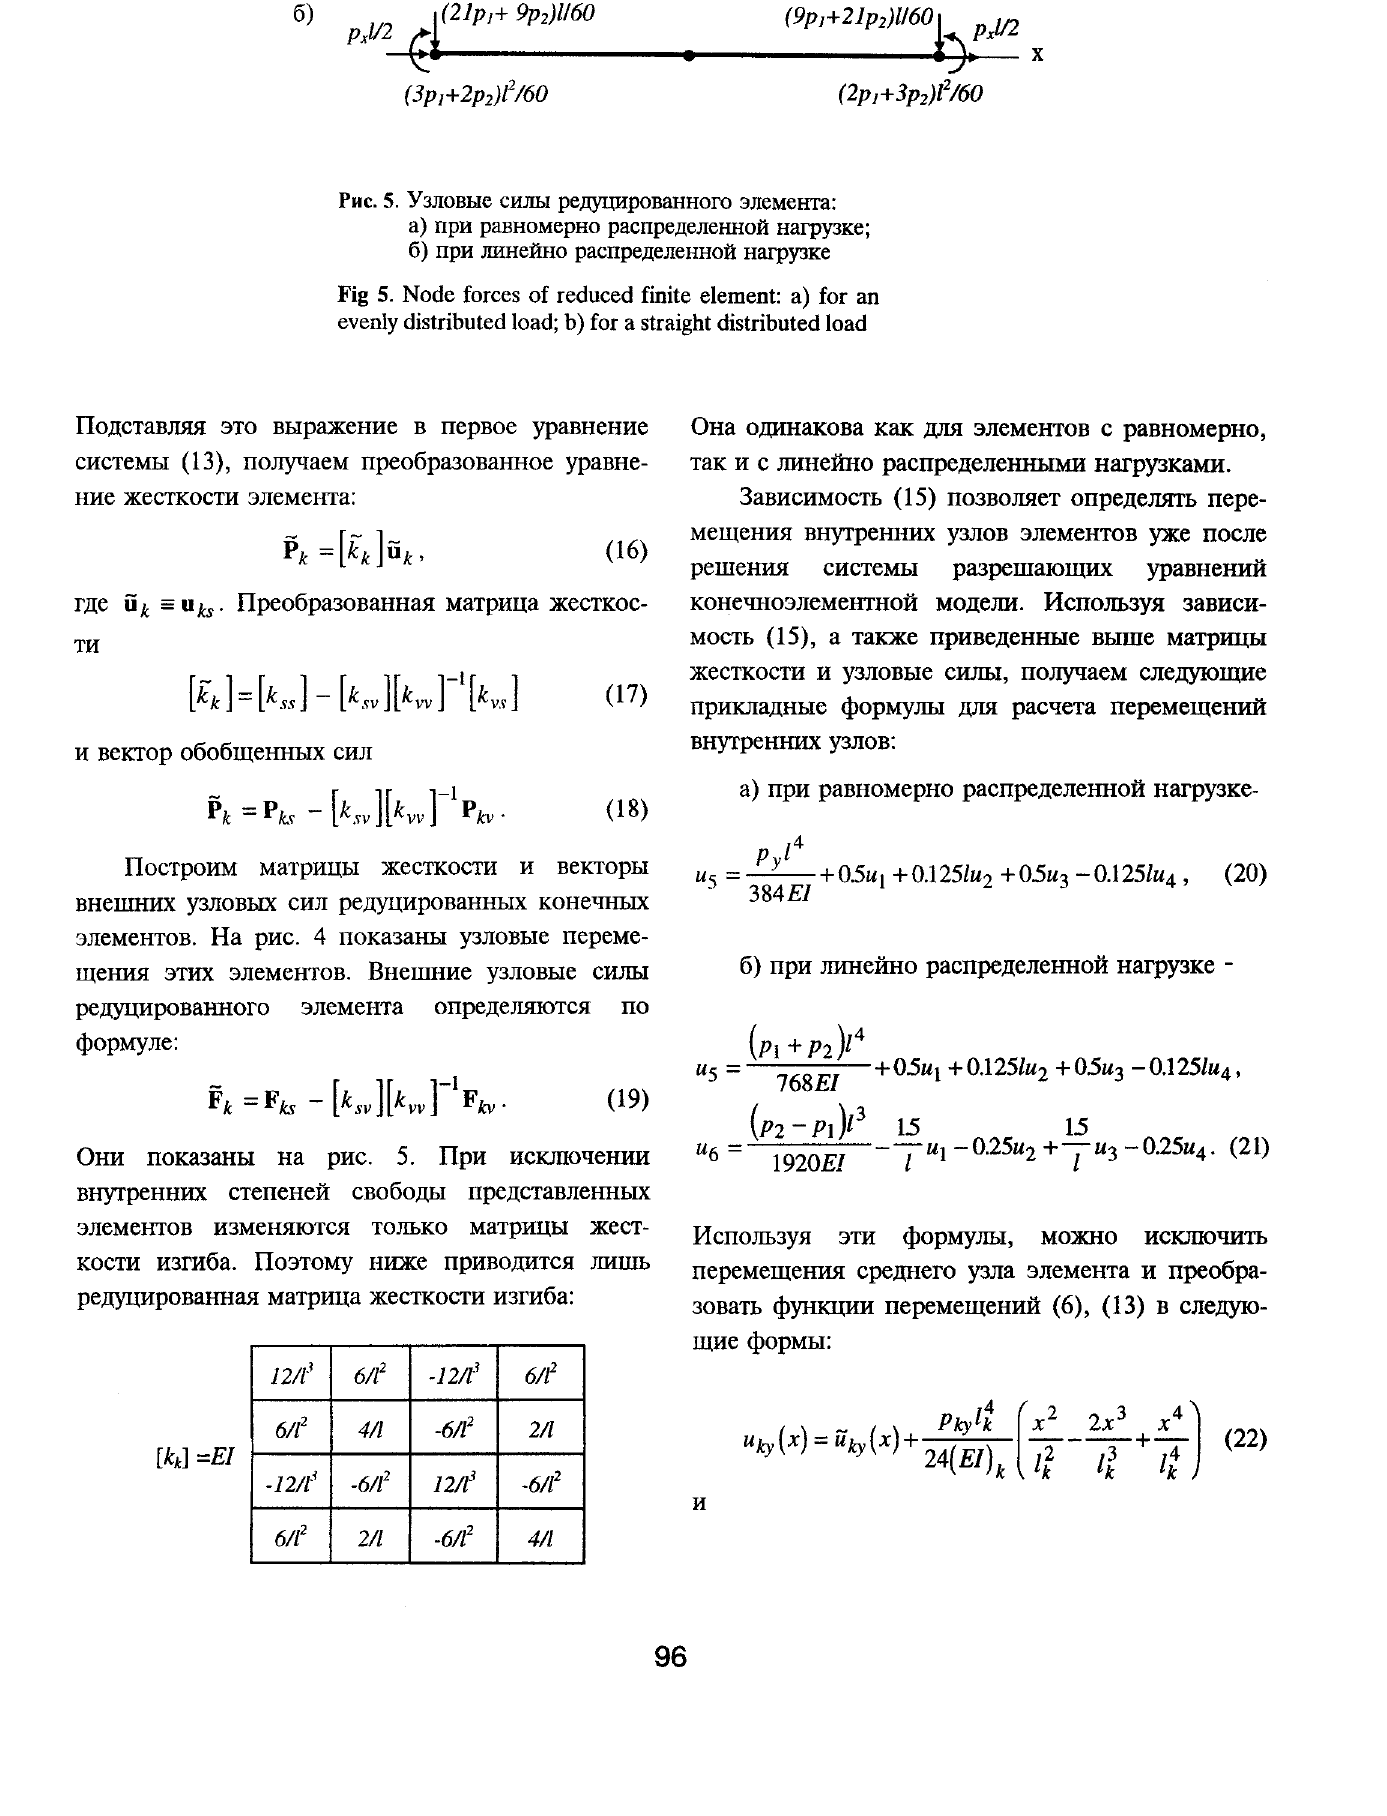
Fig 5. Node forces of reduced finite element: a) for an evenly distributed load; b) for a straight distributed